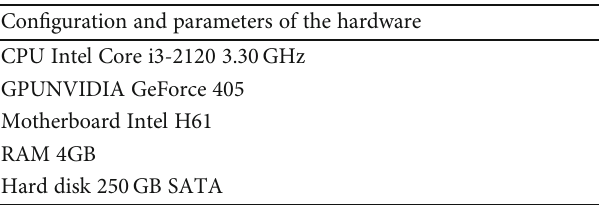
Figure 13: E ff ect of spatial track editing: (a) the original spatial tracks; (b) triangular meshes consist of spatial tracks and concave hull; (c) deformation e ff ect after dragging the point in red circle along arrow direction; (d) editing